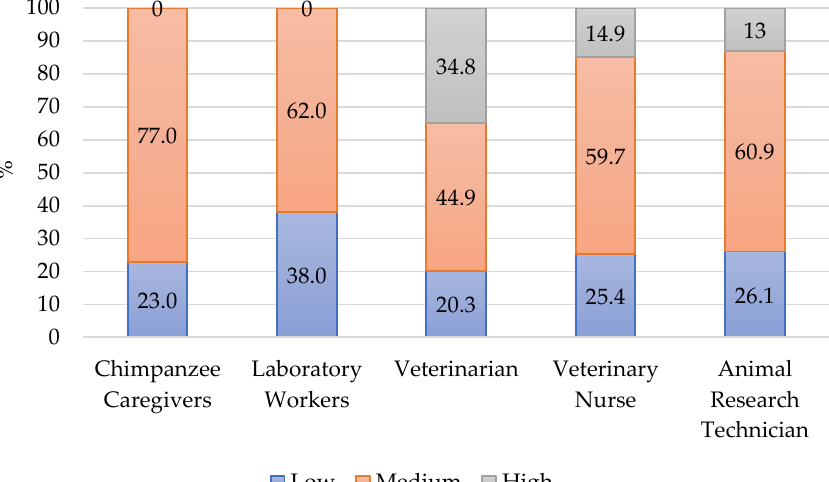
Figure 2. Percent of respondents in each category for BO. Laboratory Workers (N = 170) [21], Veterinarian (N = 69) [12], Veterinary Nurse (N = 23) [12], Animal Research Technician (N = 23) [12].